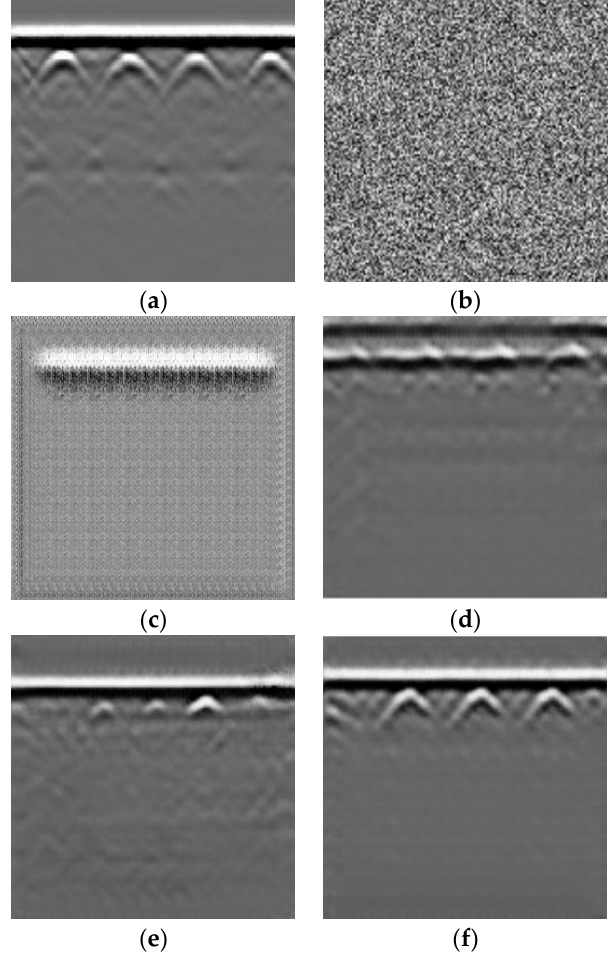
Figure 5. Generated GPR images using the improved LSGAN at different training epochs. ( a ) GPR image, ( b ) input image, ( c ) Epoch 10, ( d ) Epoch 100, ( e ) Epoch 200, ( f ) Epoch 500.